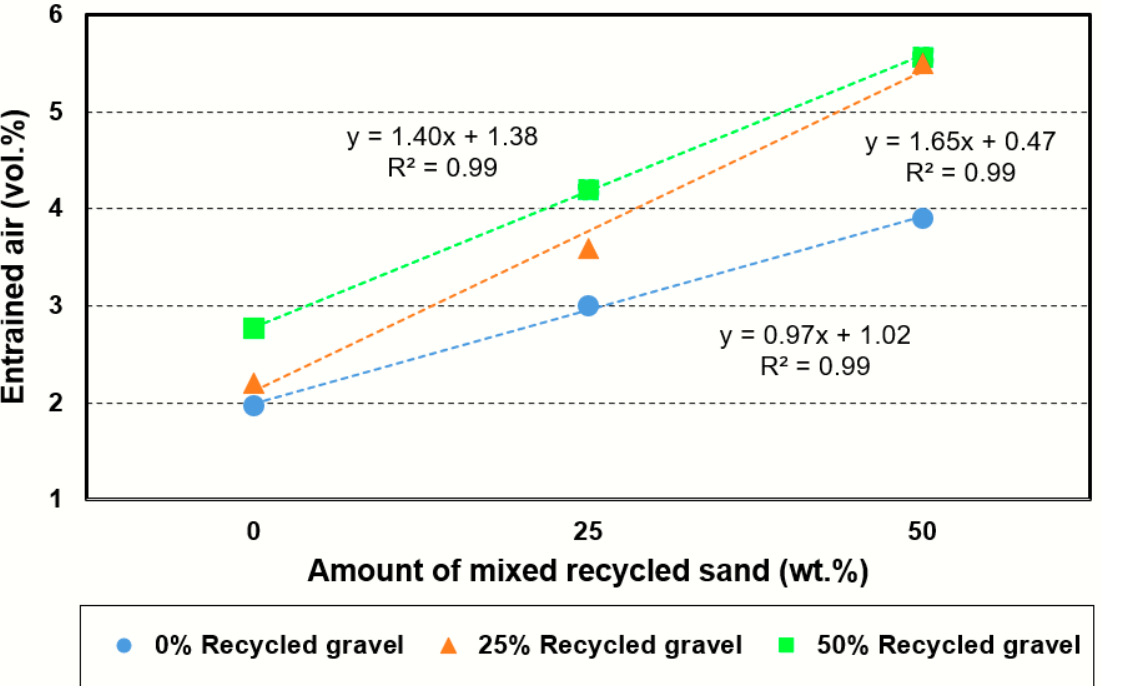
Figure 5. Connection between the percentage of mixed recycled sand and entrained air.